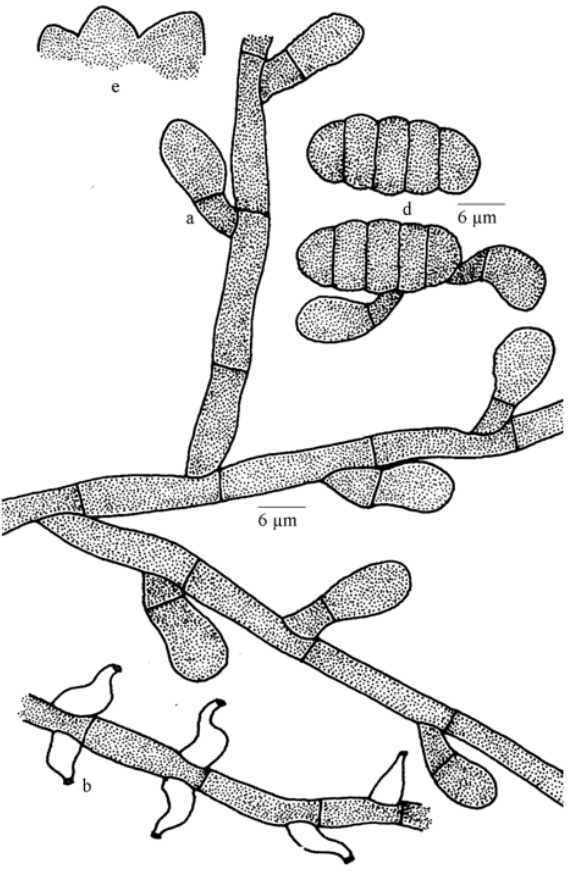
Figure 17. Asteridiella formosensis a - Appressorium; b - Phialide; d - Ascospores; e - Perithecial wall